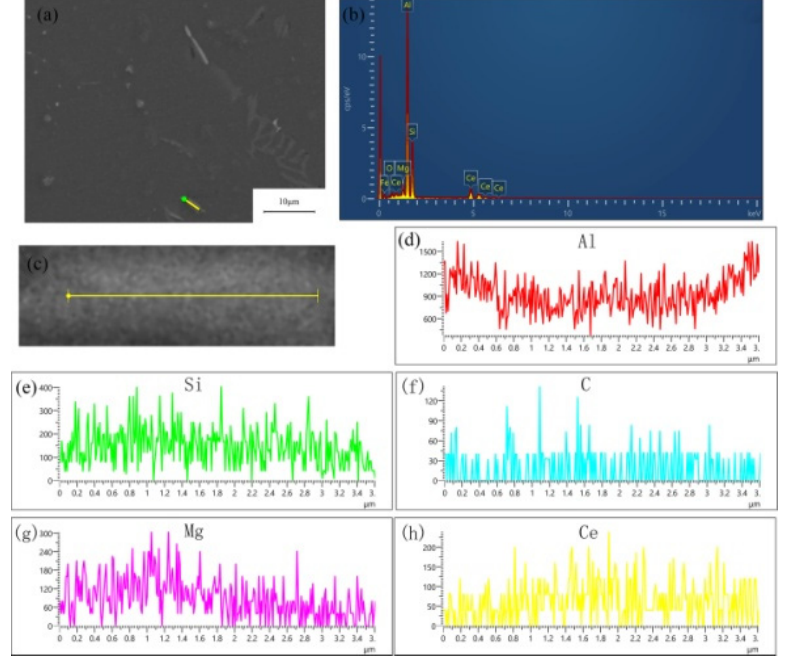
Figure 16. (AlSiFeCe) phase in A357 alloy. ( a ) Detecting position, ( b ) EDS analysis, ( c ) Line scanning position, ( d ) Al element, ( e ) Si element, ( f ) C element, ( g ) Mg element, ( h ) Ce element.